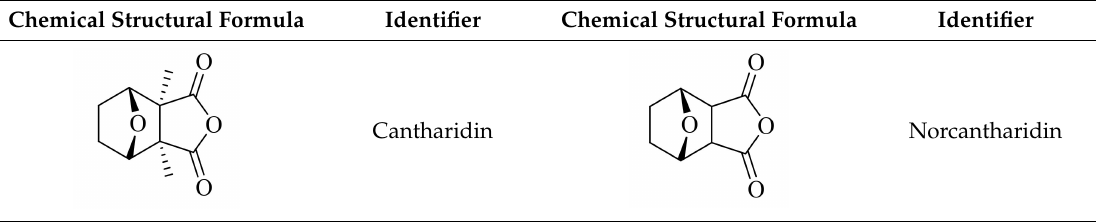
Table 1. Chemical structural formula and identifier of cantharidin and analogues. Chemical Structural